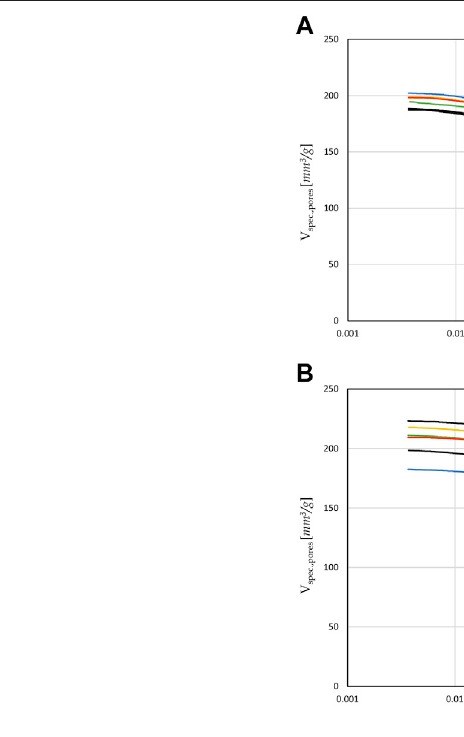
Frontiers in Materials |